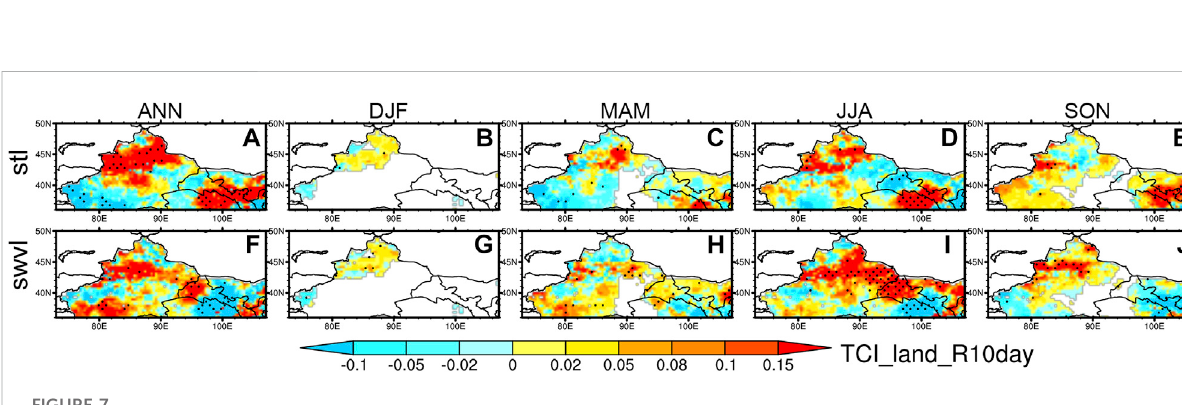
FIGURE 7 Spatial distributions of the annual and seasonal coupling index of stl1 and swvl1 with R10day. The rest of the caption is the same as in Figure